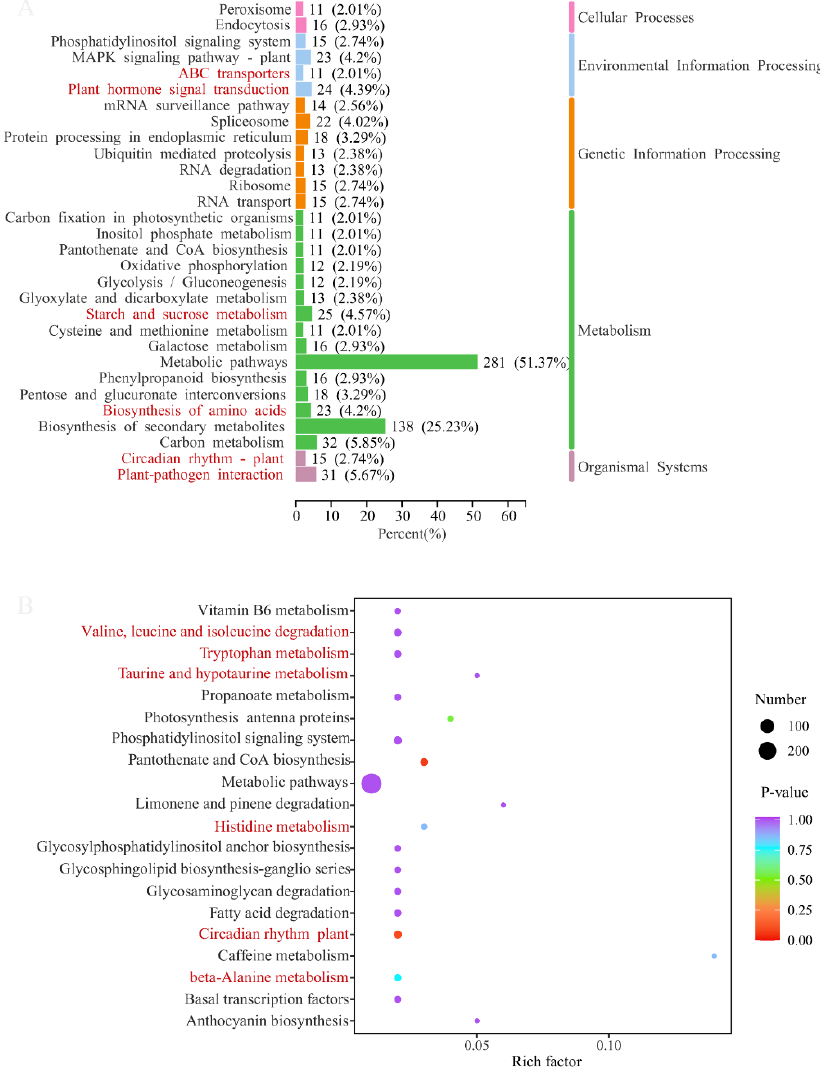
Figure 9. The main annotation results of difference genes between ASY and SY in F. cirrhosa . ( A ) KEGG classification analysis. ( B ) The enrichment analysis. ASY: aberrant six-year samples. SY: six-year samples.